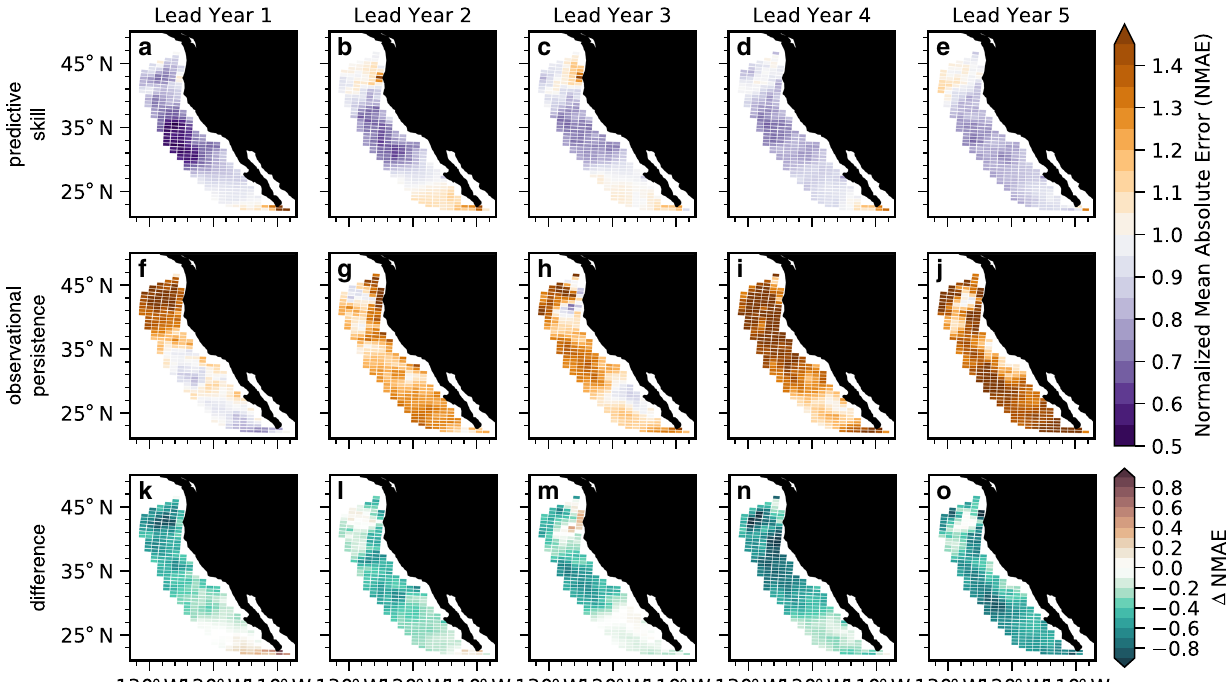
Fig. 6 Normalized bias of surface pH anomaly forecasts. a – e Normalized mean absolute error (NMAE) of Community Earth System Model Decadal Prediction Large Ensemble (CESM-DPLE) initialized forecasts of detrended annual surface pH anomalies for lead years one through fi ve relative to the observational product over 1990 – 2005. f – j NMAE of a persistence forecast for the observations for lead years one through fi ve. Purple colors (values below one) indicate that the forecast error is smaller than the interannual variability of observations; orange colors (values above one) indicate that the forecast error is larger than the interannual variability of observations. k – o Difference between the CESM-DPLE forecast and observational persistence NMAEs. Green colors indicate that the initialized forecasts have lower error than the persistence forecast.